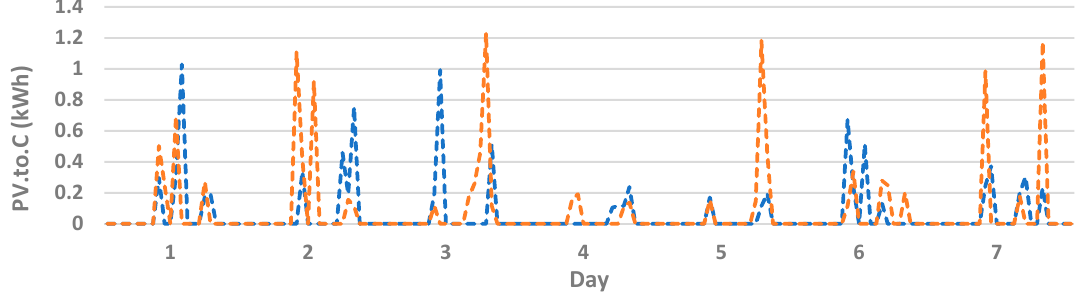
Figure 6. Energy transmission from PV panels to loads for a single dwelling. Comparison between the most and least probable scenarios (blue and orange) for one week of April. Source: self-elaboration.